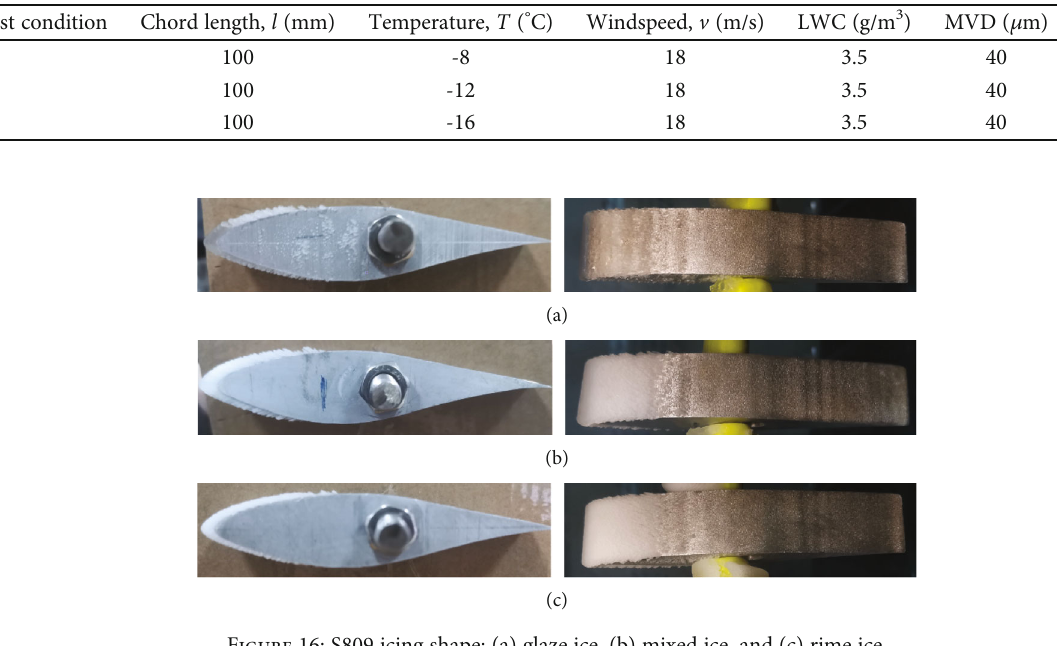
Table 3: Asymmetric airfoil icing